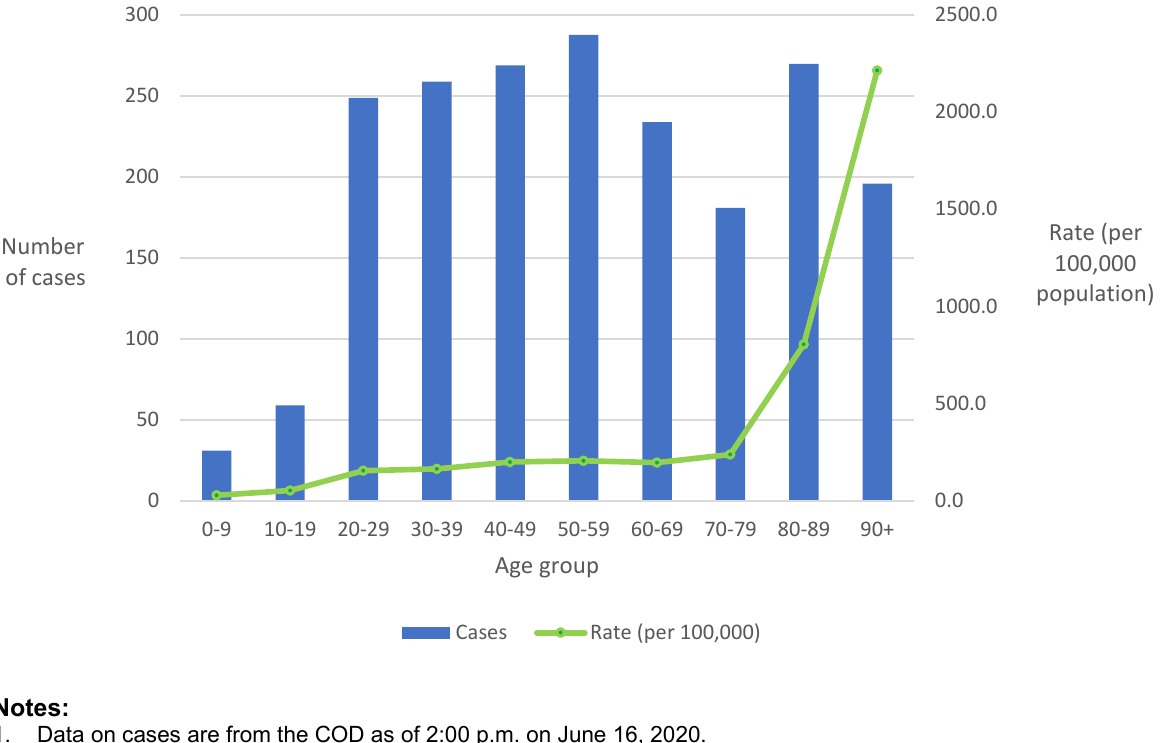
Figure 1: Ottawa residents with confirmed COVID-19 (n=2,036), by age